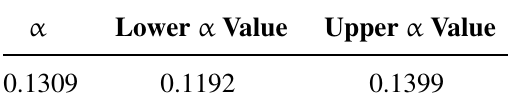
Table 4. The median wind shear factor α and its 95% bootstrap confidence